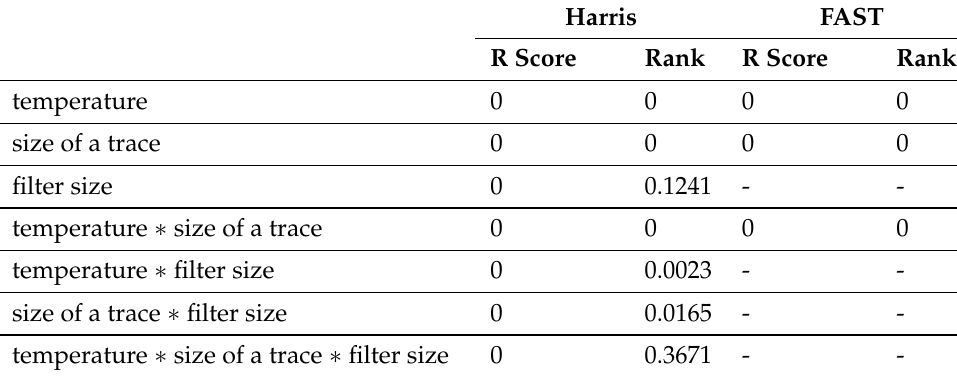
Table 1. The p -values of three-way ANOVA for the R score and the ranking for Harris and FAST algorithms. If the p -value is less than 10 − 17 , it is replaced with 0 in the Table. Symbol ( ∗ ) denotes the results of interaction between